Question: In a single sentence, describe what this figure presents.
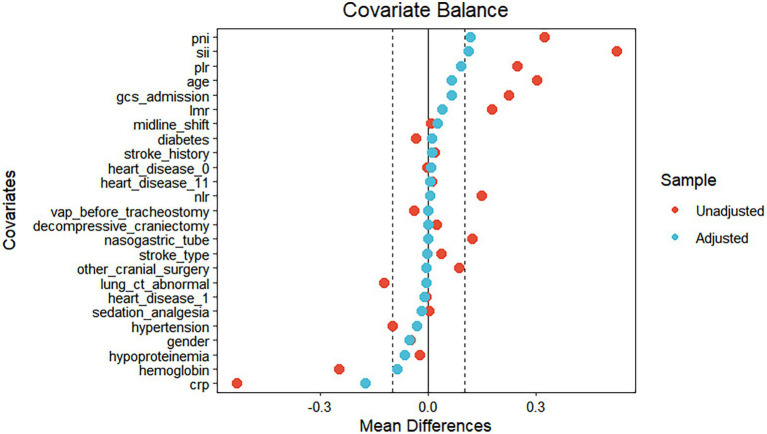
Answer: Changes in standardized mean difference (SMD) of each covariate before and after IPTW weighting.